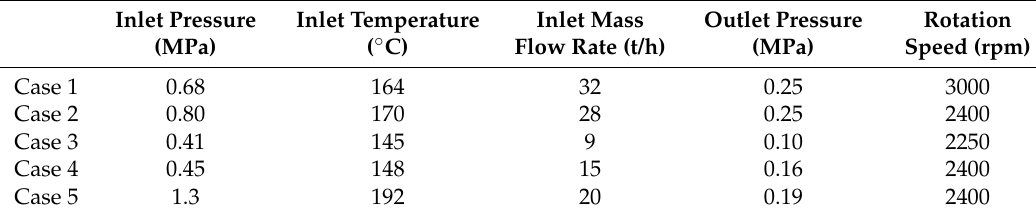
Table 2. Operation conditions of different cases.